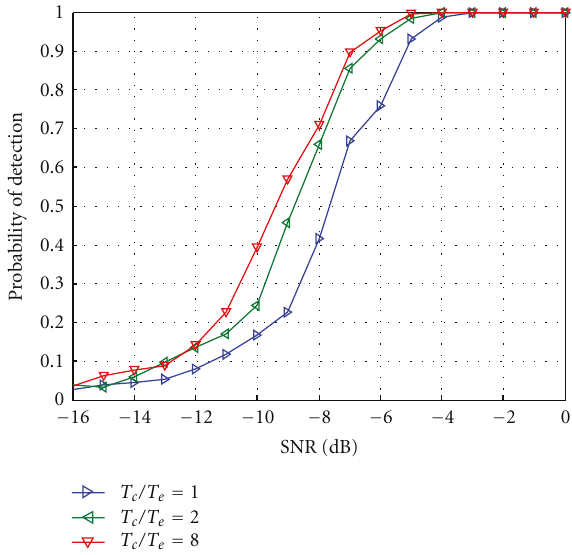
Figure 6: Influence of W ( N = 64, D = 16, U = 5, N b = 2, T c /T e = 1)